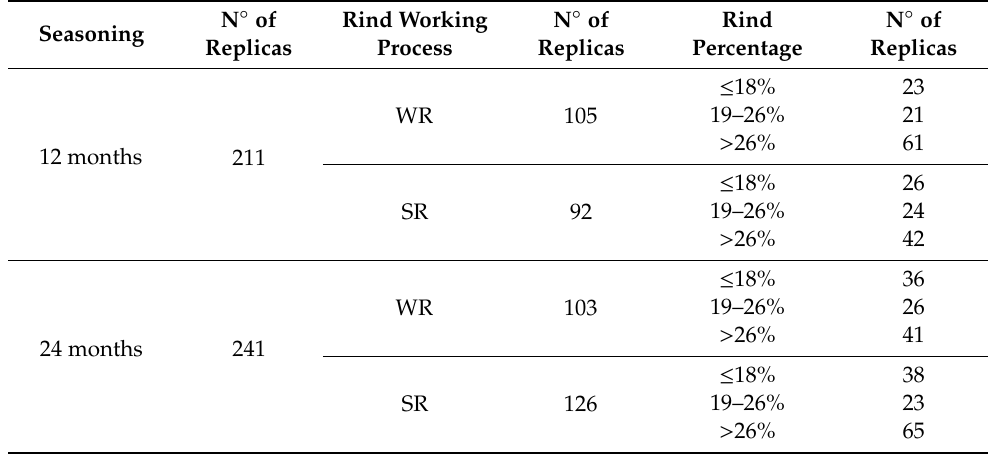
Table 1. List of the analyzed samples and number of replicas, divided according to rind percentage, ripening, and rind working process. N ◦ of Rind Working N ◦ of Seasoning Replicas